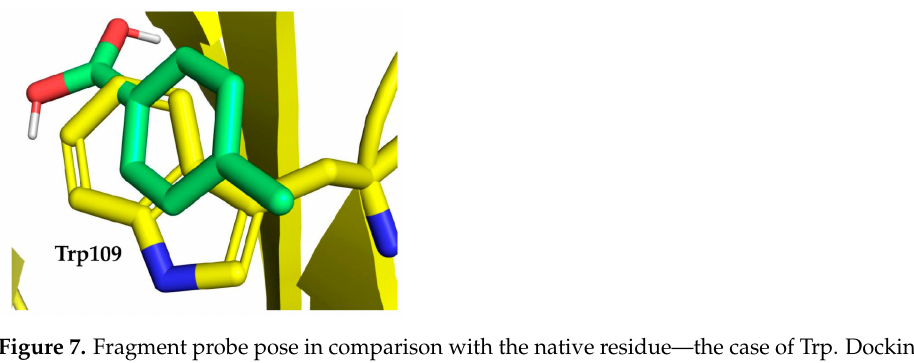
Figure 6. Best fragment poses for Tyr mutation. ( a ) Docking pose numbers 3, 4, and 7 for p -toluene boronic acid fragment probe in comparison with the native residues chain A Tyr173 and 140, mutated to Gly; ( b ) Docking pose numbers 4, 5, 7, 9, and 20 for phenylboronic acid fragment probe in comparison with the native residues chain A Tyr173 and 140, mutated to Ala; ( c ) Docking pose number 10 for phenylboronic acid fragment probe in comparison with the native residues chain A Tyr192 and 186, mutated to Ala; ( d ) Docking pose numbers 11 and 16 for phenylboronic acid fragment probe in comparison with the native residue chain B Tyr200, mutated to Ala; ( e ) Docking pose numbers 11 and 14 for p -toluene boronic acid fragment probe in comparison with the native residue chain B Tyr200.